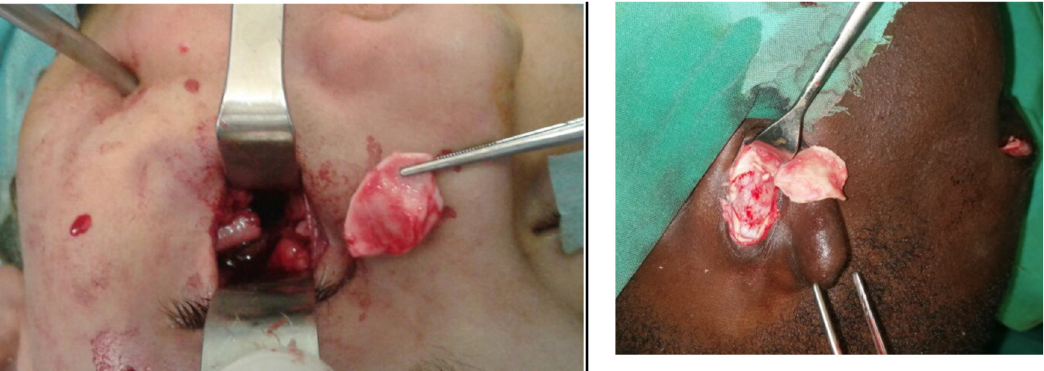
Fig. 5. Reconstruction of the fl oor from an auricular graft in the patient on the left. Harvesting site of auricular cartilage by retro-auricular access in the patient on